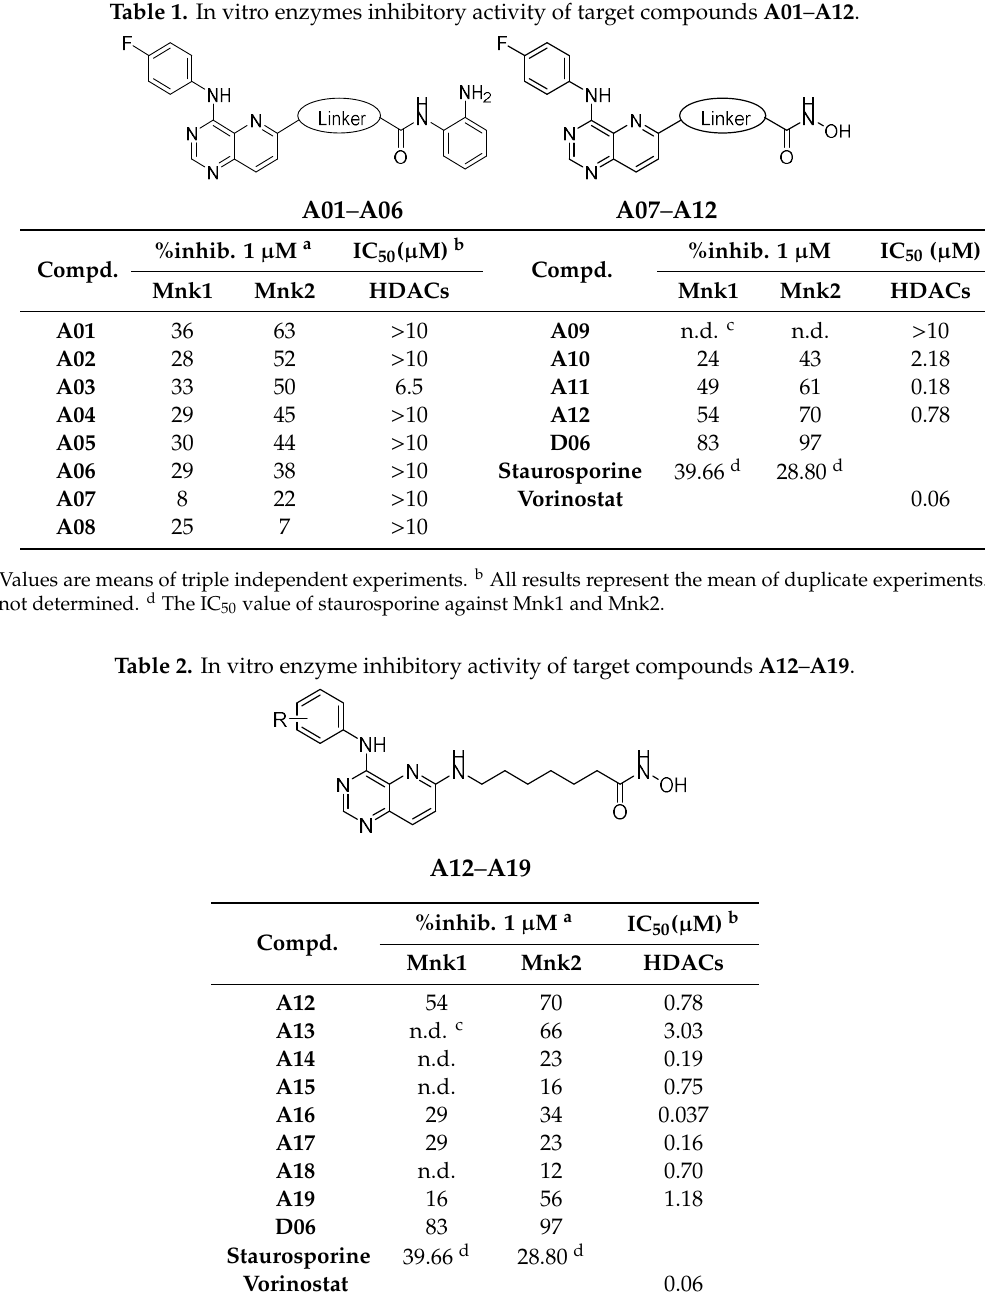
Table 2. In vitro enzyme inhibitory activity of target compounds A12 – A19 . Compd.